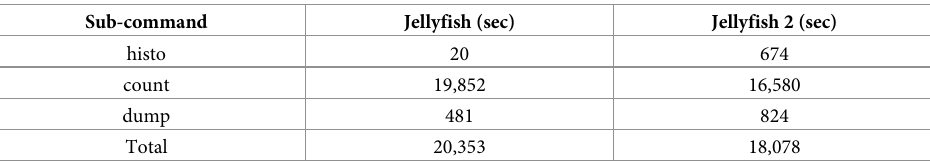
Table 2. Comparison of running times of Jellyfish and Jellyfish